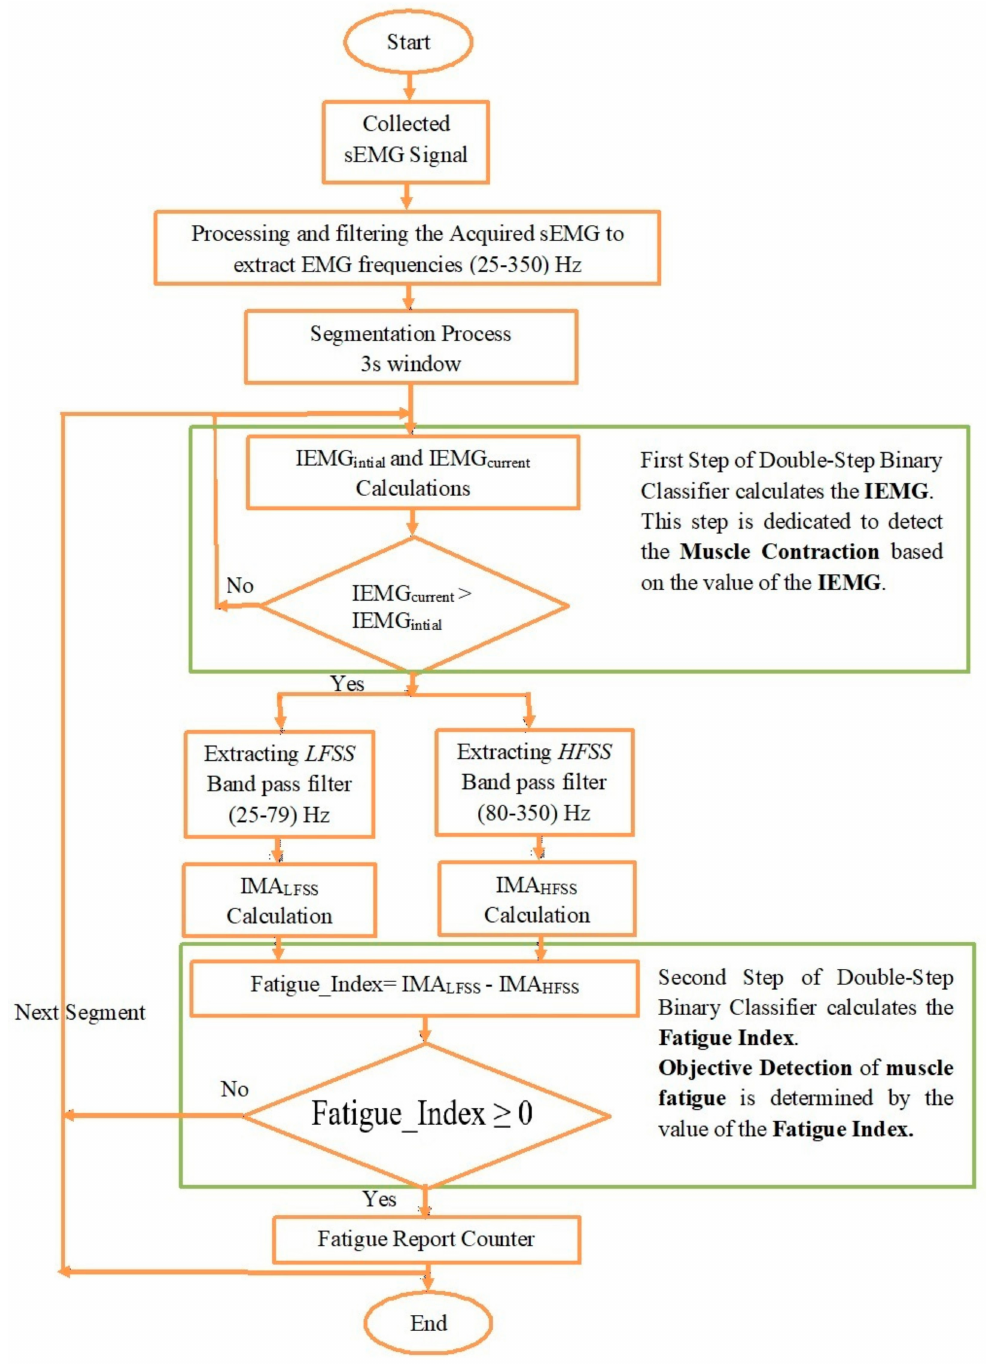
Figure 4. Flow chart of the proposed